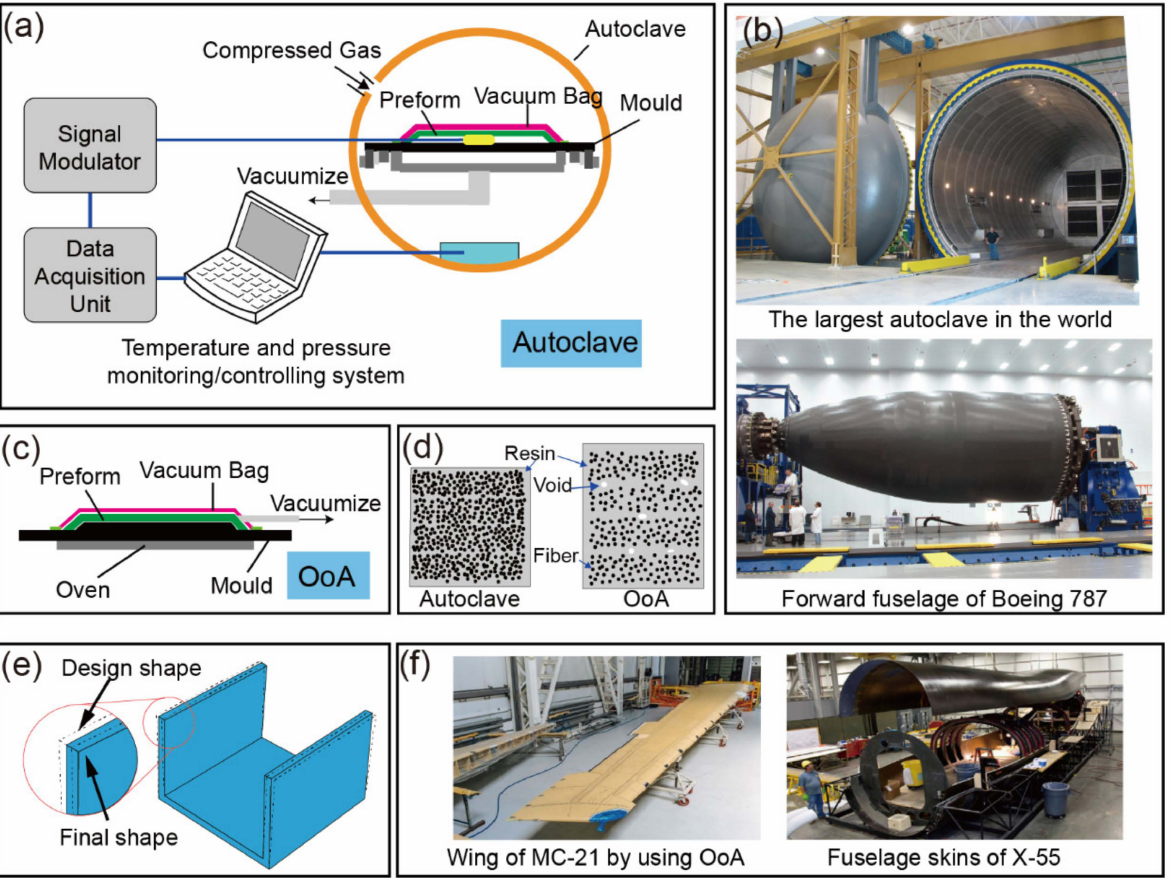
Figure 2. Autoclave and OoA molding technology. ( a ) Autoclave and the temperature and pressure monitoring/controlling system, ( b ) The largest autoclave in the world from Boeing Company in Chicago, USA (Ref. [27]. 2012, ACS Process Systems), and the forward fuselage of Boeing 787 (Ref. [28]. 2018, TESLARATI), ( c ) Schematic diagram of OoA; ( d ) Schematic diagram of the cross sections of composites molded by autoclave or OoA, ( e ) Curing deformation schematic diagram in autoclave molding process, and ( f ) The wing of MC-21 (Ref. [17]. 2021, Simple Flying) and the fuselage skin of X-55, an advanced composite cargo aircraft, molding by OoA process (Ref. [29]. 2009,